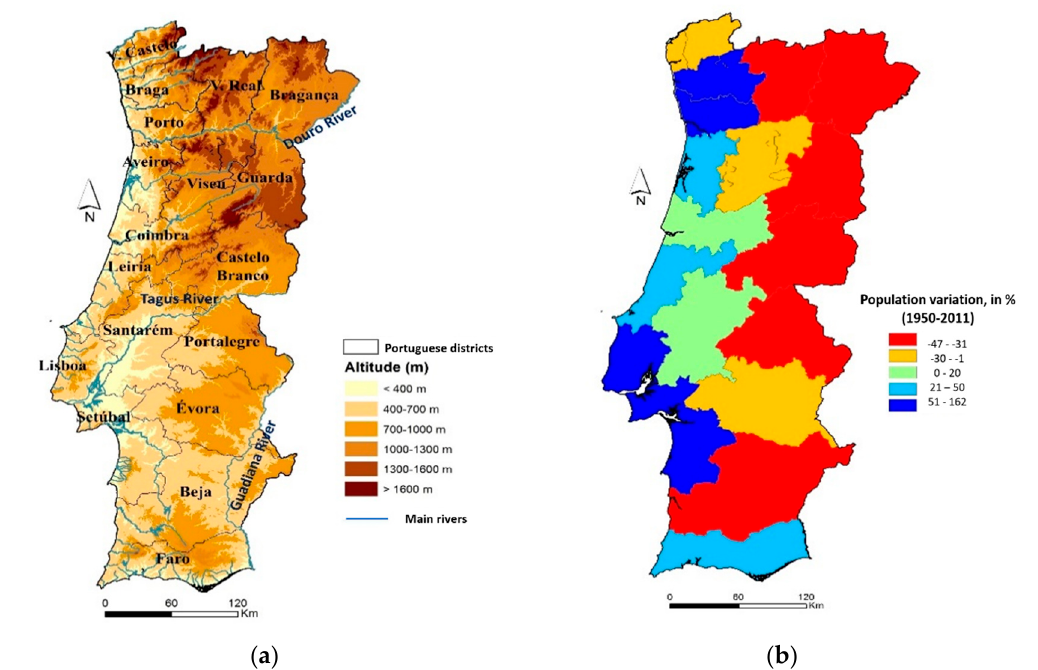
Figure 1. Mainland Portugal: ( a ) Variation in altitude; ( b ) Percentage of population variation by district, between 1950 and 2011.